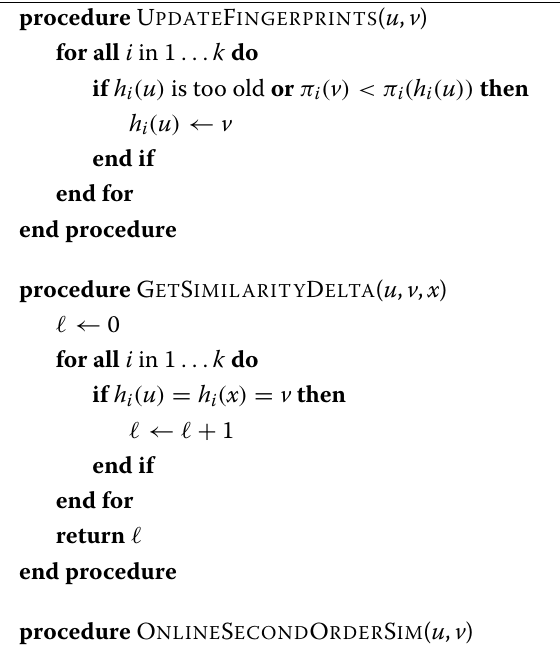
Algorithm 2 Online learning second order similarity